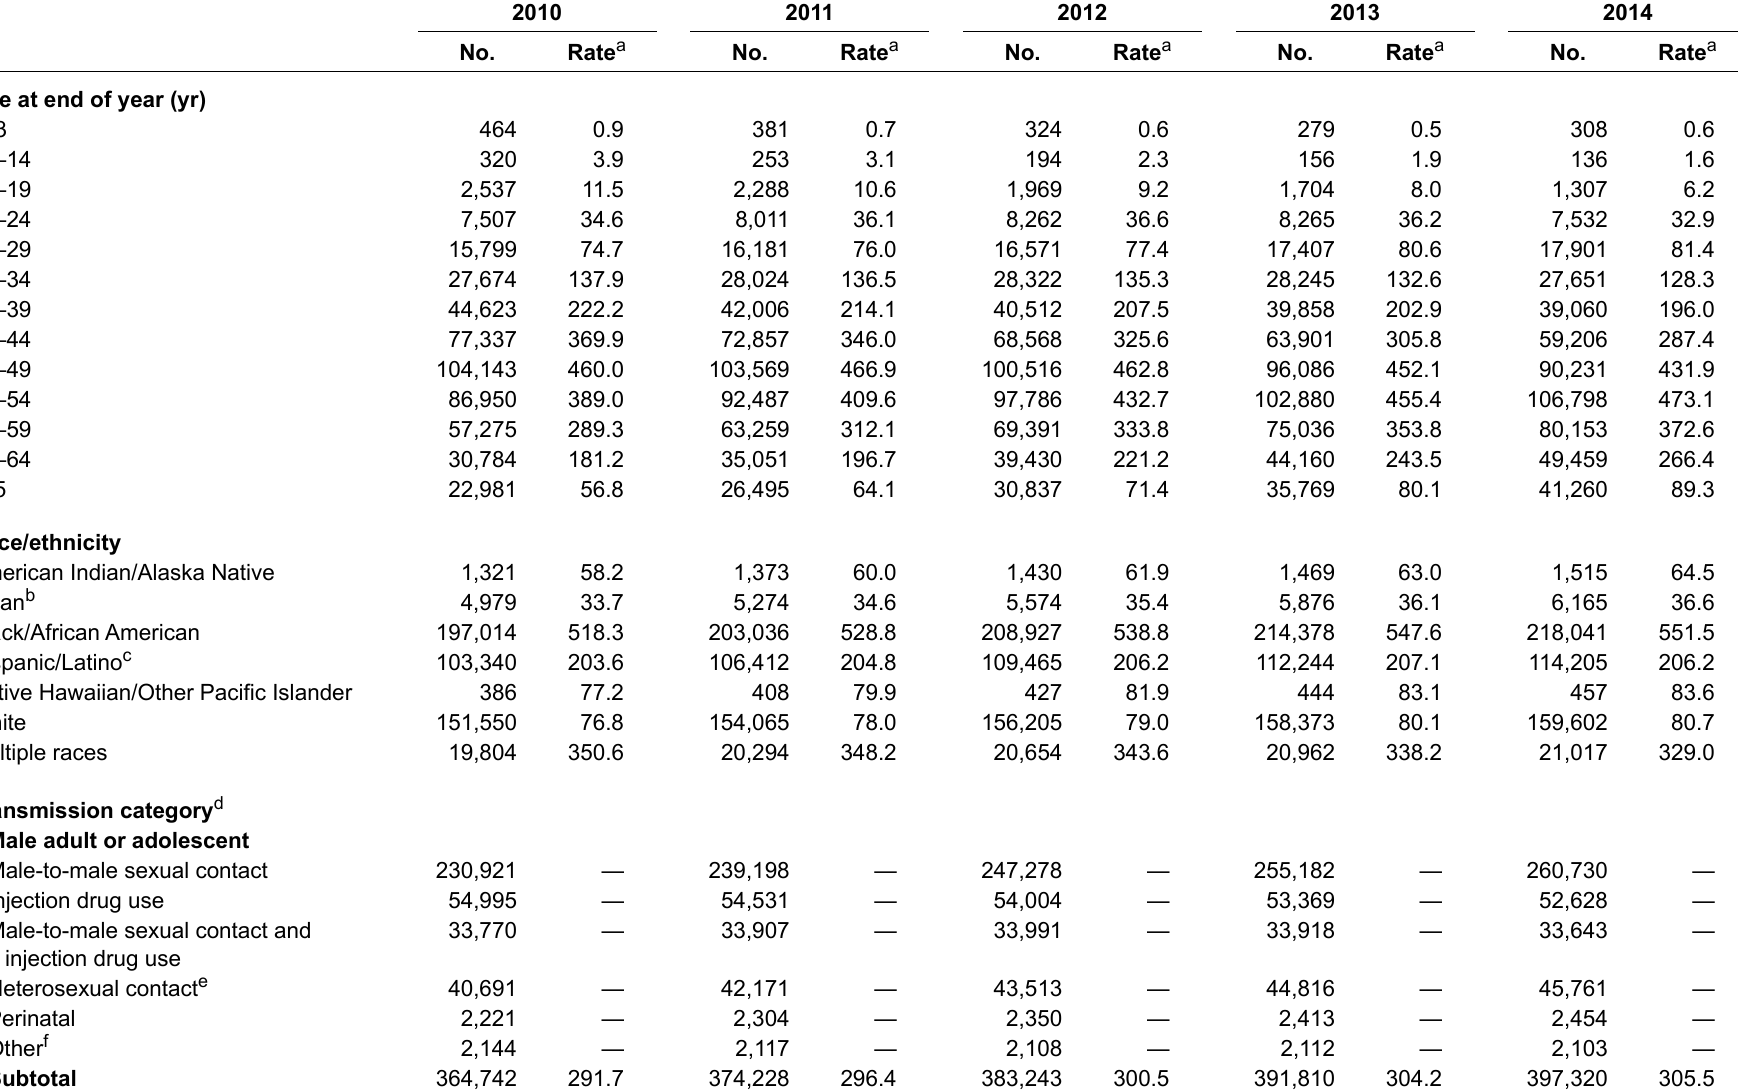
Table 19a. Persons living with diagnosed HIV infection ever classified as stage 3 (AIDS), by year and selected characteristics, 2010–2014—United